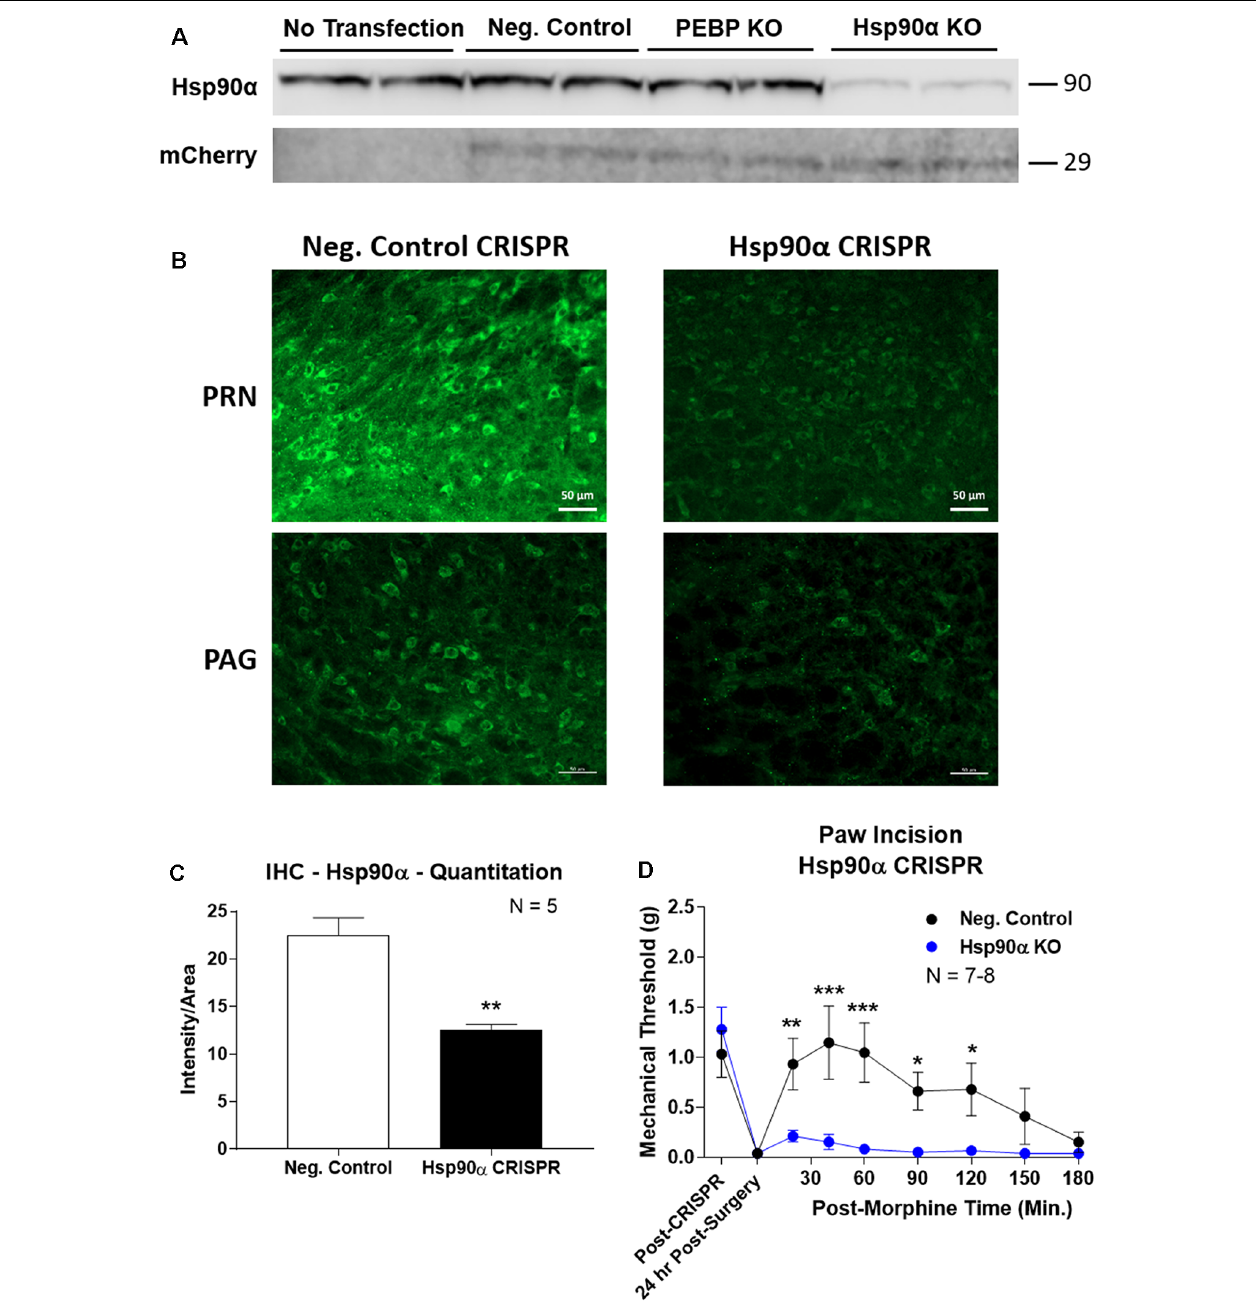
FIGURE 3 | CRISPR/Cas9 gene editing of Hsp90 α in adult mouse brain. CRISPR constructs for all targets prepared and delivered as described in “Materials and Methods” section. All quantitative data reported as mean ± SEM. (A) Hsp90 α CRISPR construct validated in 66.1 cells. Western blot shown with replicate wells of cells in each lane, with MW indicated for each target. Hsp90 α protein levels reduced by ∼ 90% only in the presence of Hsp90 α -targeted CRISPR construct. Other constructs (Negative Control, PEBP) have no effect. mCherry protein levels are present in all transfected cells, demonstrating successful transfection of CRISPR DNA. (B) Hsp90 α or negative control CRISPR delivered to CD-1 male mouse brains and analyzed for protein knockdown on day 10. Representative images shown from pontine reticular nucleus (PRN) and periaqueductal gray (PAG). Hsp90 α (green signal) is present in cell bodies and dendritic trees, and the signal is reduced by CRISPR treatment. (C) Quantitation of all data from (B) performed as described in “Materials and Methods” section. Sample size of mice/group noted in graph. ∗∗ p < 0.01 vs. Negative Control group by Unpaired 2-Tailed t -test. Mice treated in one technical replicate, with the resulting tissue stained and analyzed in more than one technical replicate. CRISPR treatment reduced Hsp90 α signal by 43.9%. (D) CRISPR-treated CD-1 male mice had paw incision surgery performed on day 9, with injection of 3.2 mg/kg morphine sc on day 10. Sample size of mice/group noted in graph, performed in two technical replicates. ∗ , ∗∗ , ∗∗∗ p < 0.05, 0.01, 0.001 vs. same time point Hsp90 α group by two-way ANOVA with Fisher’s Least Significant Difference post hoc test.